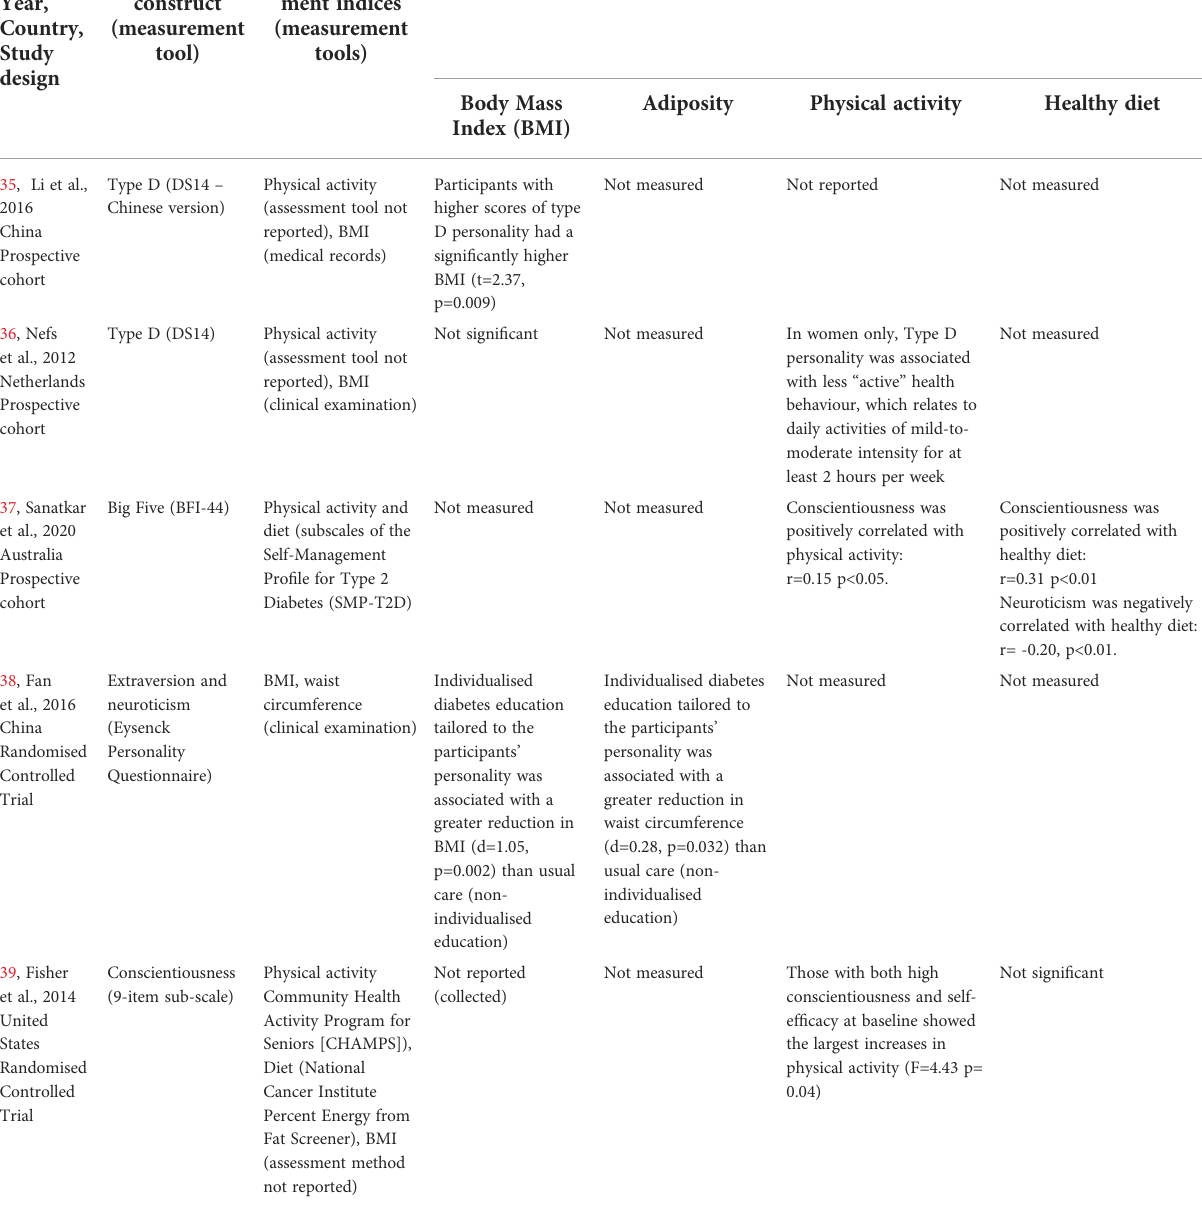
traits and weight management indicators. In summary,